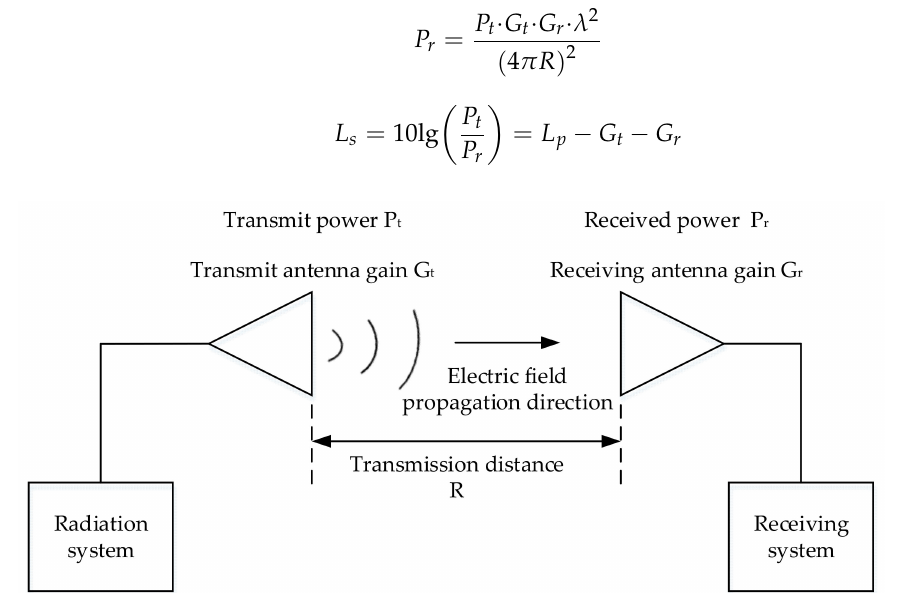
Figure 9. Schematic diagram of Friis transmission formula in free